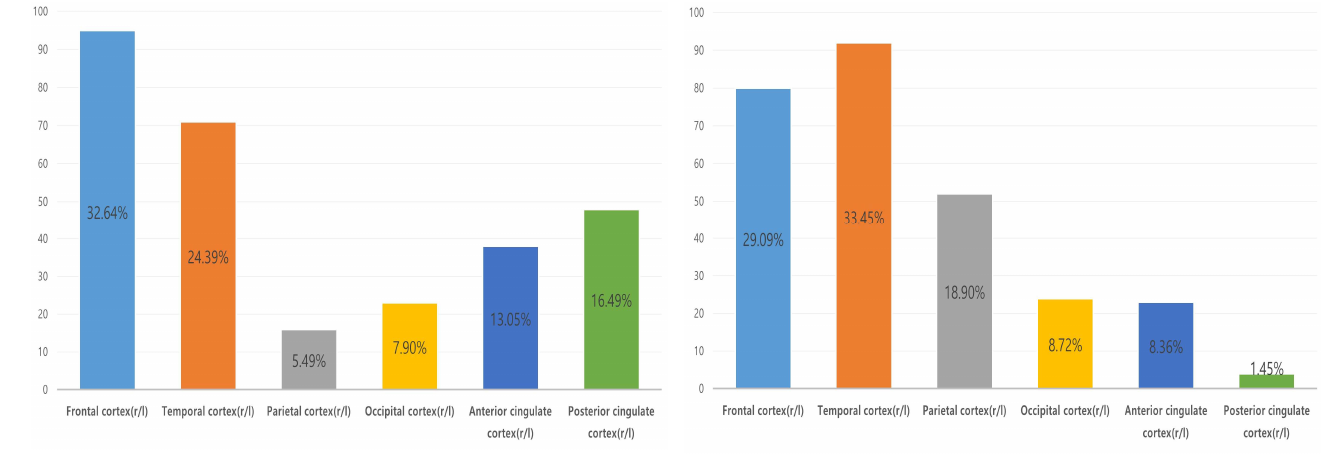
Figure 6. Histogram of frequency-based analysis: ( a ) distribution of eFBB and ( b ) distribution of dFBB. eFBB: early-phase FBB, dFBB: delay-phase FBB. Table 4. Simple and relative frequency distribution for feature selection in multiple training runs.